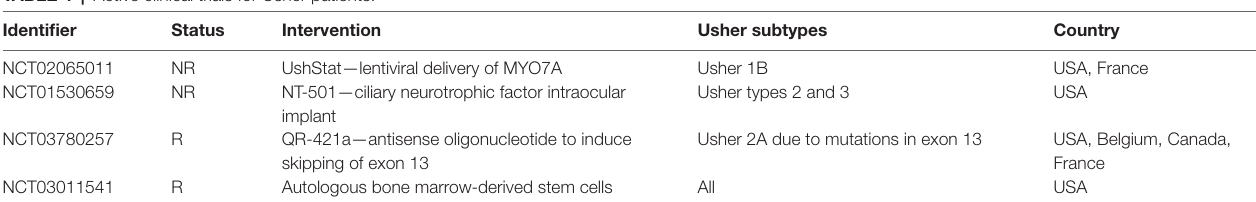
TABLE 4 | Active clinical trials for Usher